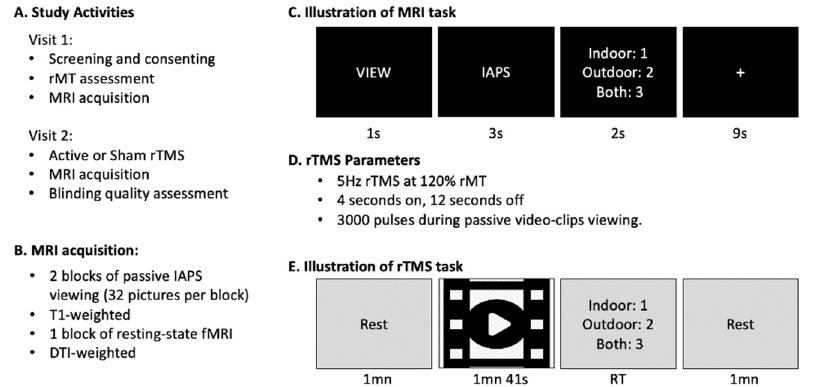
Figure 2. ( A ) Activities done during each study visit. ( B ) Scans during MRI acquisition. ( C ) Illustration of MRI task showing passive viewing of IAPS pictures. ( D ) rTMS parameters. ( E ) Illustration of rTMS task showing passive viewing of frightening video-clips from the Schaefer et al. database. In order to maintain attention in both the MRI and rTMS tasks, participants were asked to rate whether the scene was indoor, outdoor, or both.